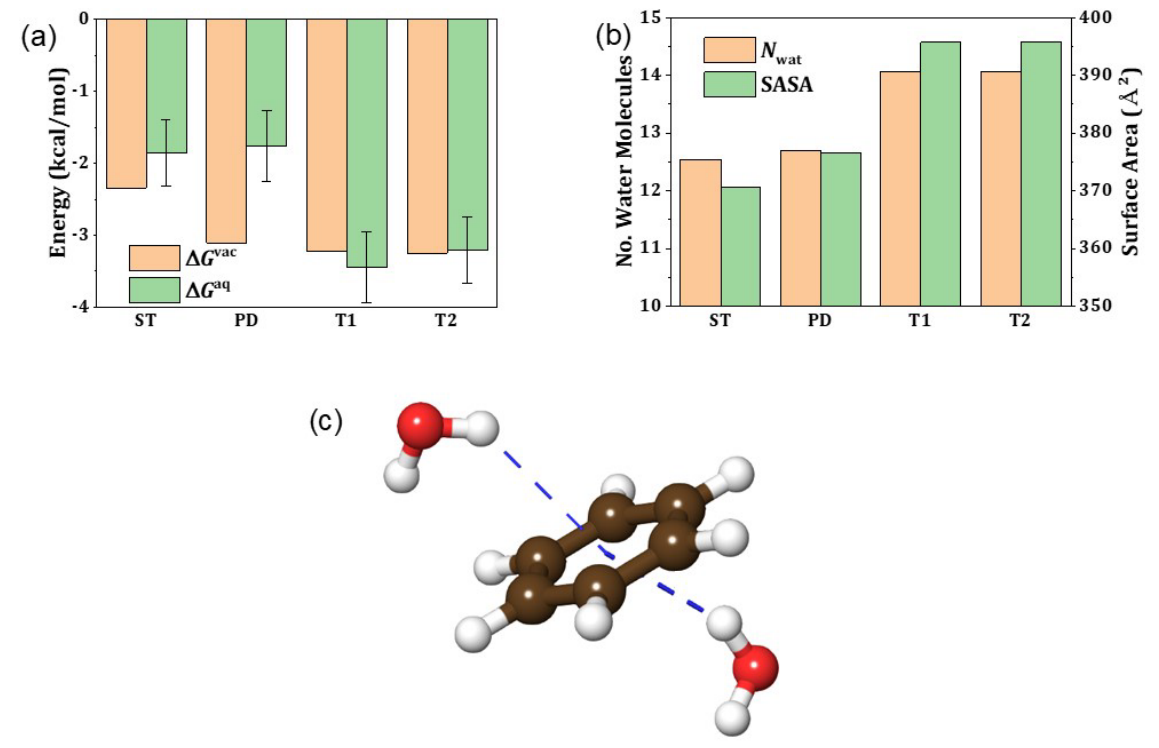
Figure 3. ( a ) Association free energy of benzene dimers in vacuum ( ∆ G vac ) and in solution ( ∆ G aq ). ( b ) Average number of water molecules in the first solvent shell ( N wat ) and solvent accessible surface area (SASA) corresponding to the benzene dimer association in water. ( c ) Schematic illustrating the face benzene–water hydrogen bonds.